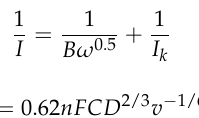
Fig. 7. Linear sweep voltammogram of